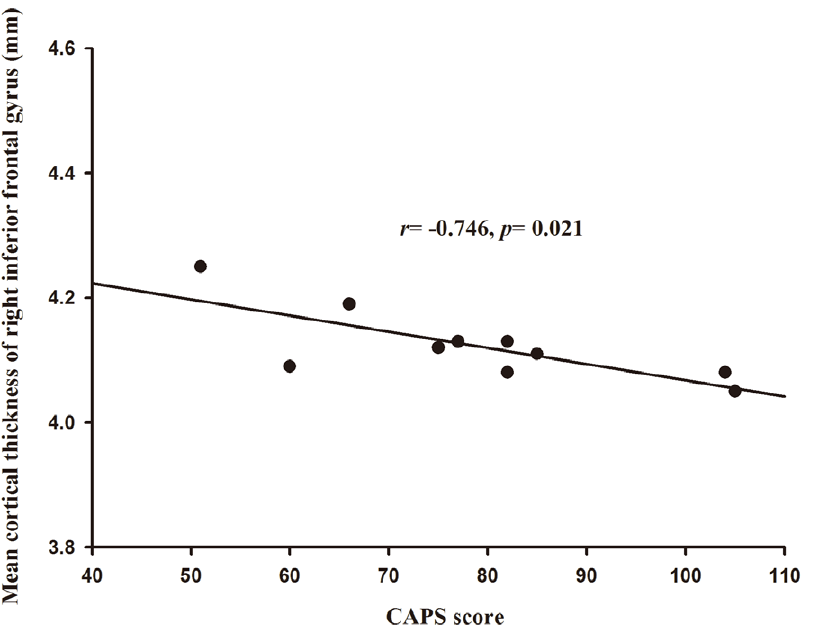
Figure 3. Mean cortical thickness of the right inferior frontal gyrus correlations with the CAPS score of PTSD patients. PTSD, post- traumatic stress disorder. r , Pearson’s correlation coefficient; p , p value.